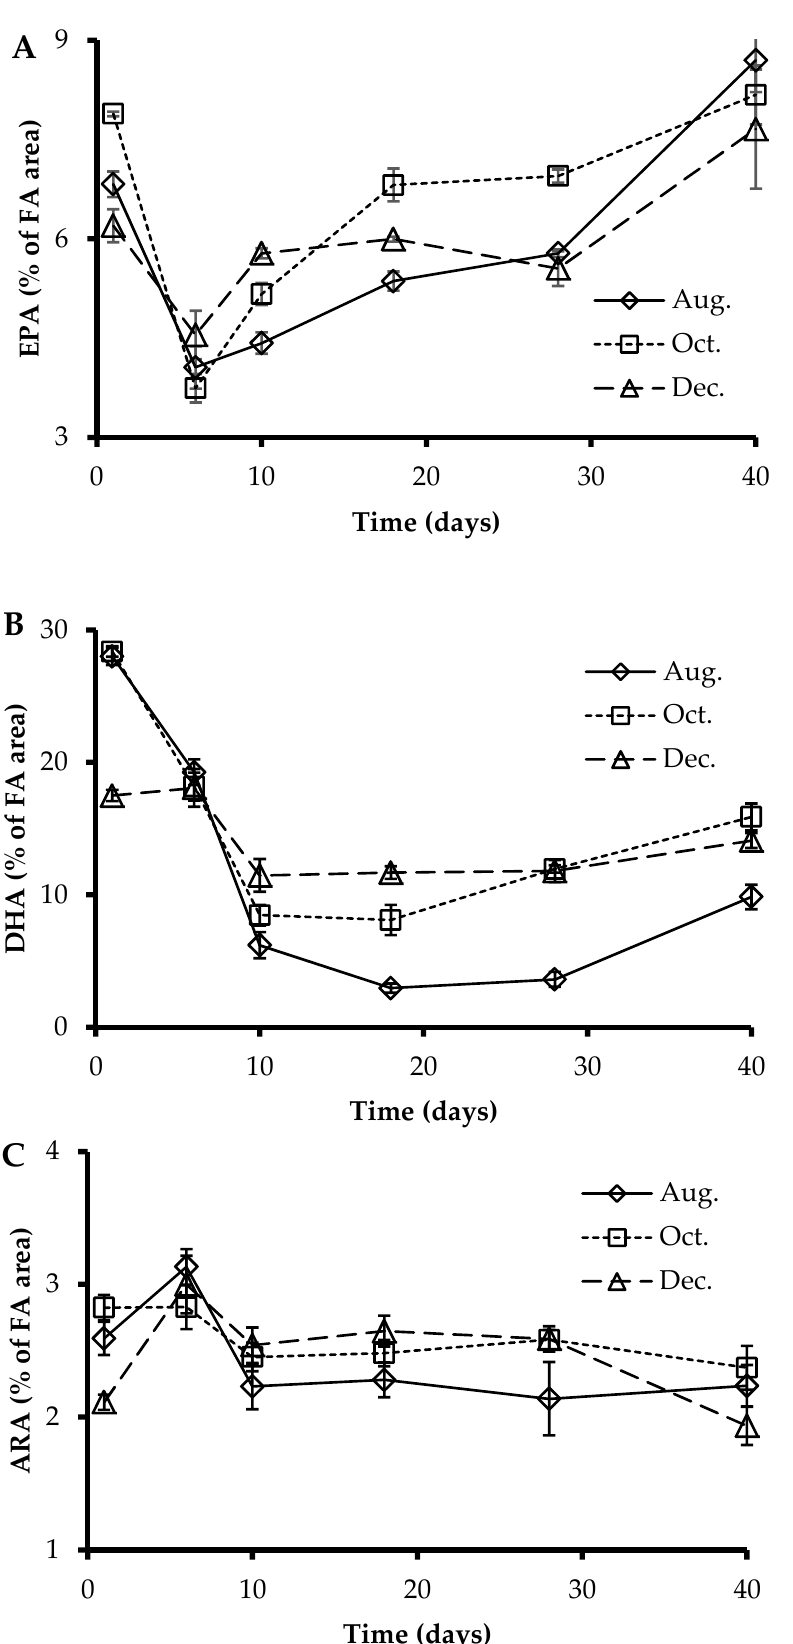
Figure 5. ( A – C ) The percentage of EPA, DHA, and ARA composition in larvae sampled in 1, 6, 10, 18, 28, and 40 dph in August, October, and December spawning events. ( D ) The percentage of DHA/EPA ratio is shown. 3.4. EPA, DHA, and ARA Content in Polar and Neutral Lipid Fraction The proportional contents of long-chain PUFA within neutral and polar lipids in 40- day-old larvae from spawns collected at di ff erent months are presented in Figure 6. In the case of EPA, it was more abundant in the neutral lipid fraction ( p = 0.004) irrespective of the sampling month so that no signi fi cant e ff ect of this factor was found ( p = 0.761). On the other hand, the percentage of DHA did depend on the sampling month, being more abundant within both neutral and polar lipids at the end of the spawning season ( p < 0.001). However, an interaction between the lipid fraction and the sampling month was slightly signi fi cant ( p = 0.042), supporting that in 40-day-old larvae hatched in August, the neutral lipids were enriched in DHA in relation to polar lipids whereas in 40-day-old lar- vae hatched in December, polar lipids were enriched in DHA in relation to neutral ones. At last, the ARA proportion a tt ained a small increase in December with respect to the val- ues observed in August ( p = 0.024), and it was clearly a ff ected by the lipid fraction ( p < 0.001), being more abundant in neutral lipids, although it was just a small di ff erence. No interaction between the two factors was detected. In general, the ARA proportions were quite stable, but the small changes that were observed were signi fi cant.